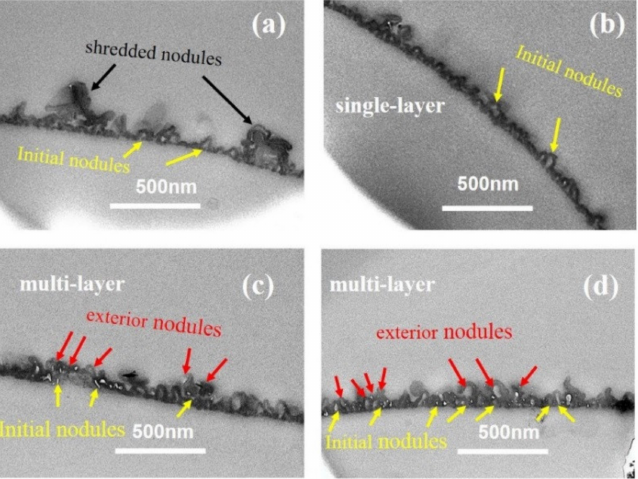
Figure 6. TEM image of cross-section parts of the PA membrane. ( a – d ): TFC − 9~TFC − 12; the cross-section of TFC − 7 and TFC − 8 could not be